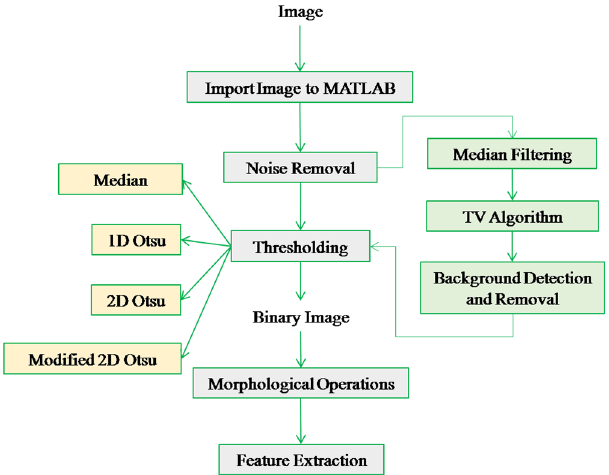
Figure 1. The overall procedure showing the different steps for processing the fluorescence microscope